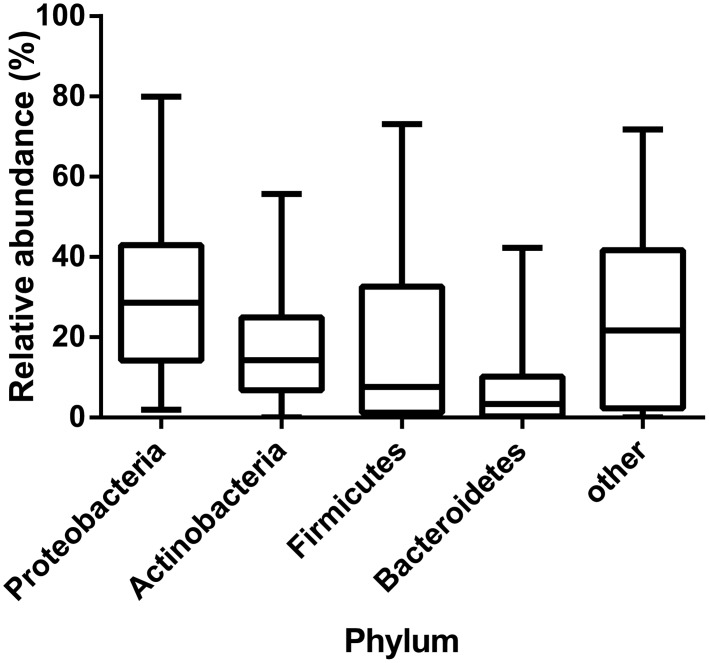
Distribution of bacterial phyla identified by 16S sequence analysis of ascites bacterial DNA.Boxes represent median values and error bars show interquartile range